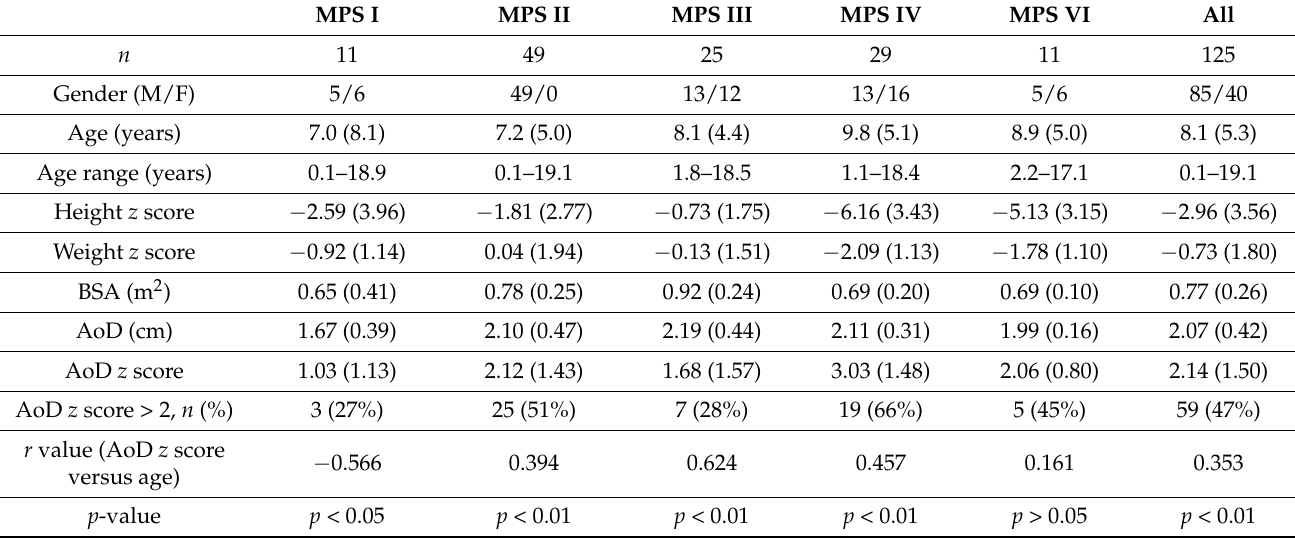
Table 1. Demographic characteristics and aortic root diameter measurements among patients with different types of mucopolysaccharidoses (MPSs) ( n = 125). MPS I MPS II MPS III MPS IV MPS